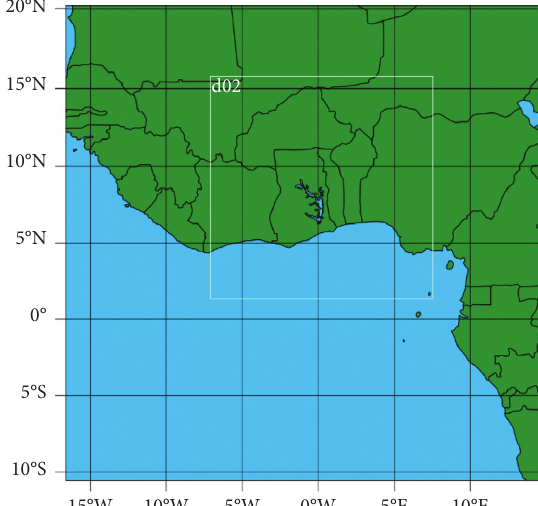
Figure 5: Two domain configurations for GMET’s WRF model. Resolutions of 27 km and 9 km (white cell),